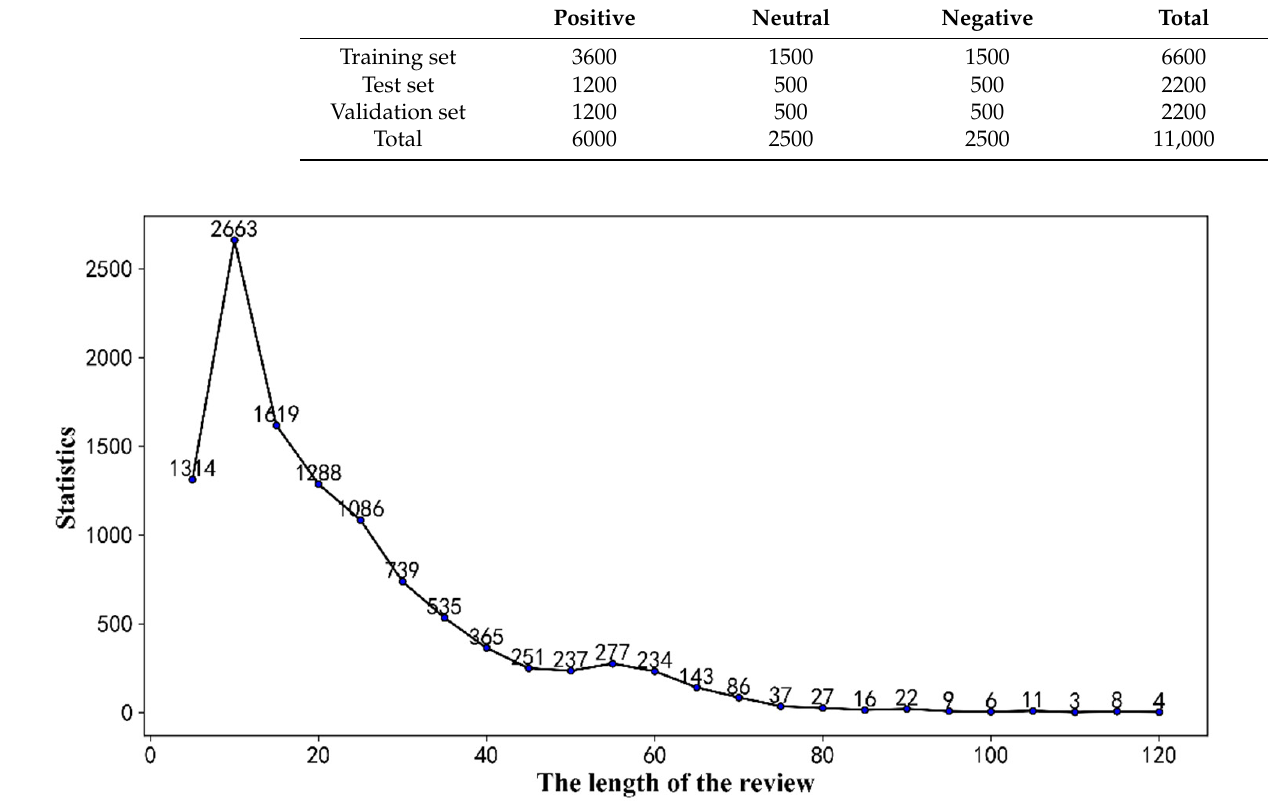
Figure 7. Length statistics of reviews.